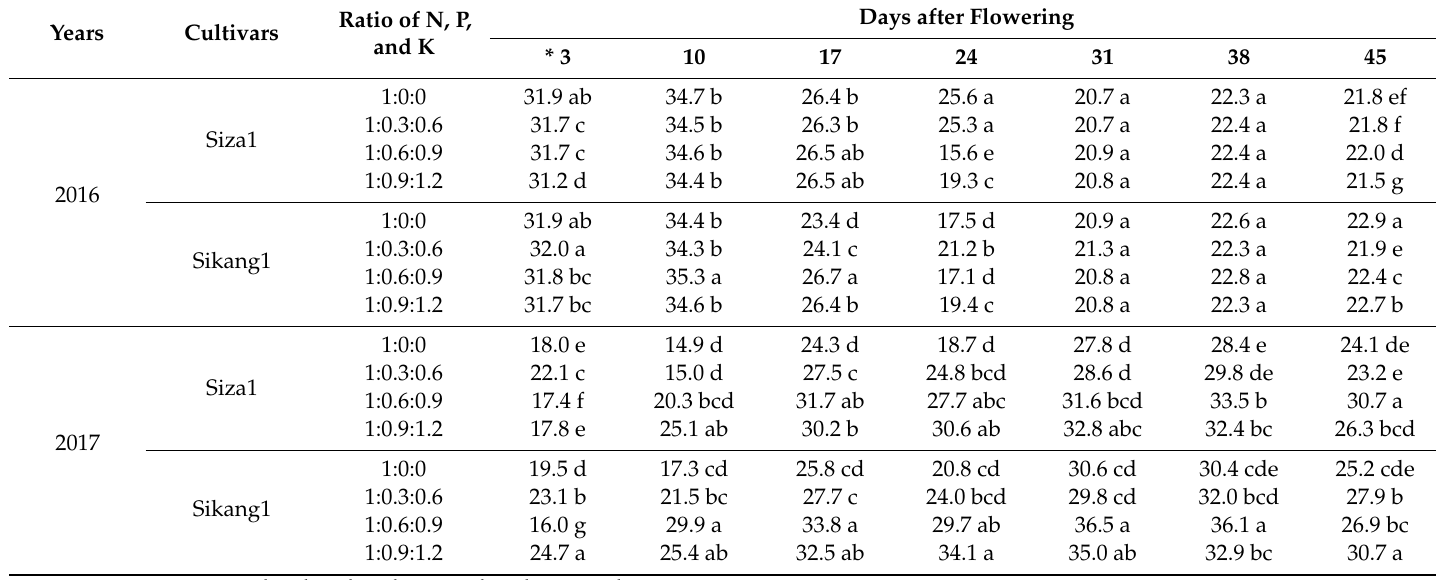
Table 10. E ff ects of the ratio of nitrogen, phosphorous, and potassium application on protein content mg g − 1 of Siza 1 and Sikang 1 during 2016 and 2017. Ratio of N, P, Years Cultivars and